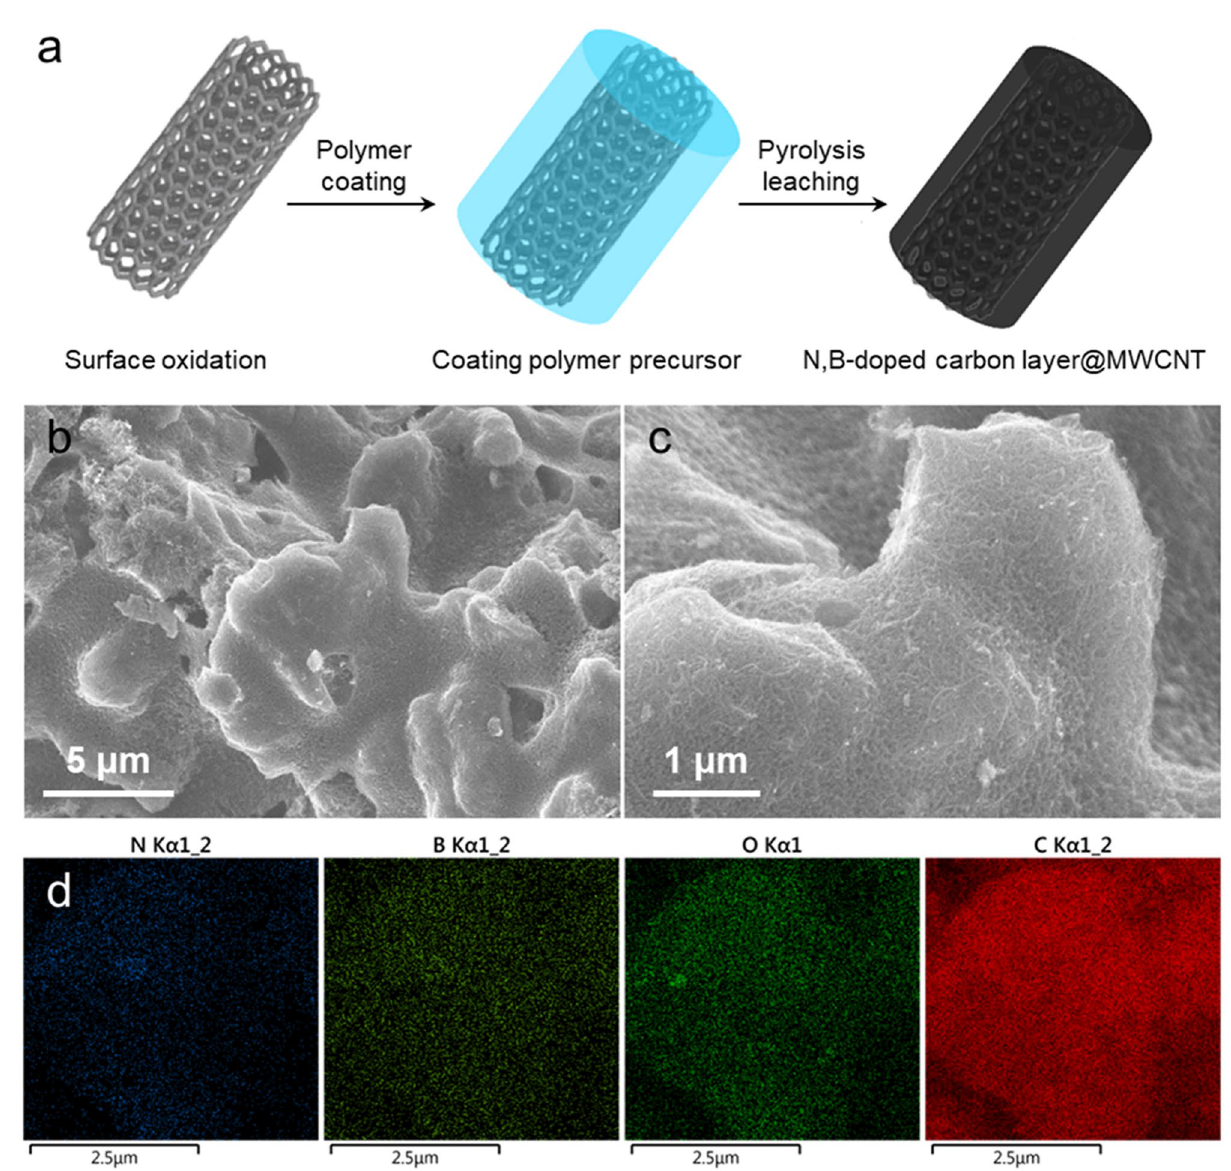
Figure 1. Structure and composition of NBC@MWCNTs. ( a ) The scheme of preparation procedure of NBC@ MWCNTs; ( b , c ) SEM morphology of NBC@MWCNTs; ( d ) Elemental distribution mapping images of elements N, B, O, and C in NBC@MWCNTs